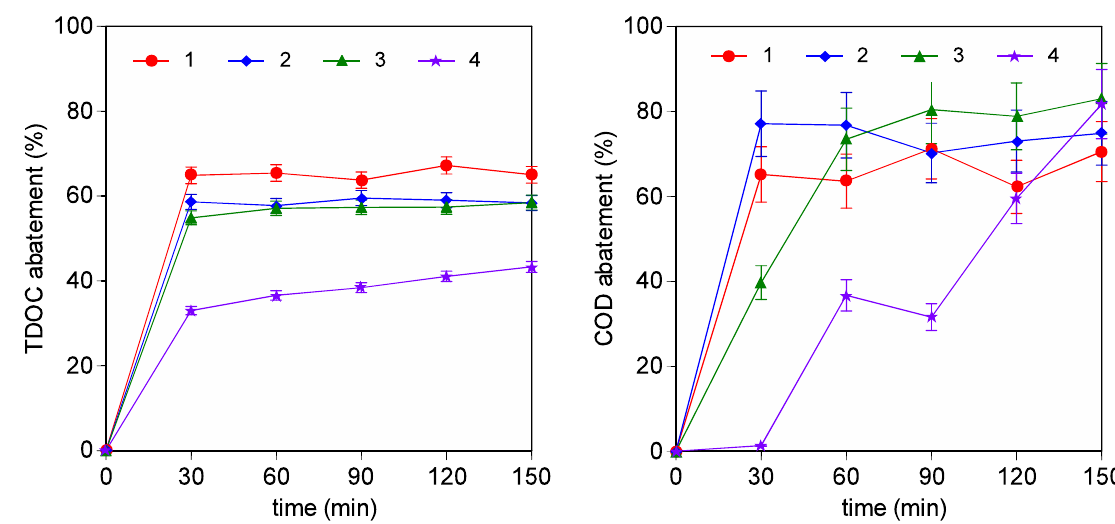
Figure 7. Effect of catalyst recycle on TDOC and COD abatements (reaction condition: 70 ◦ C, pH 5, catalyst dose 200 mg/L, H 2 O 2 dose 30 mL/L and reaction time 150